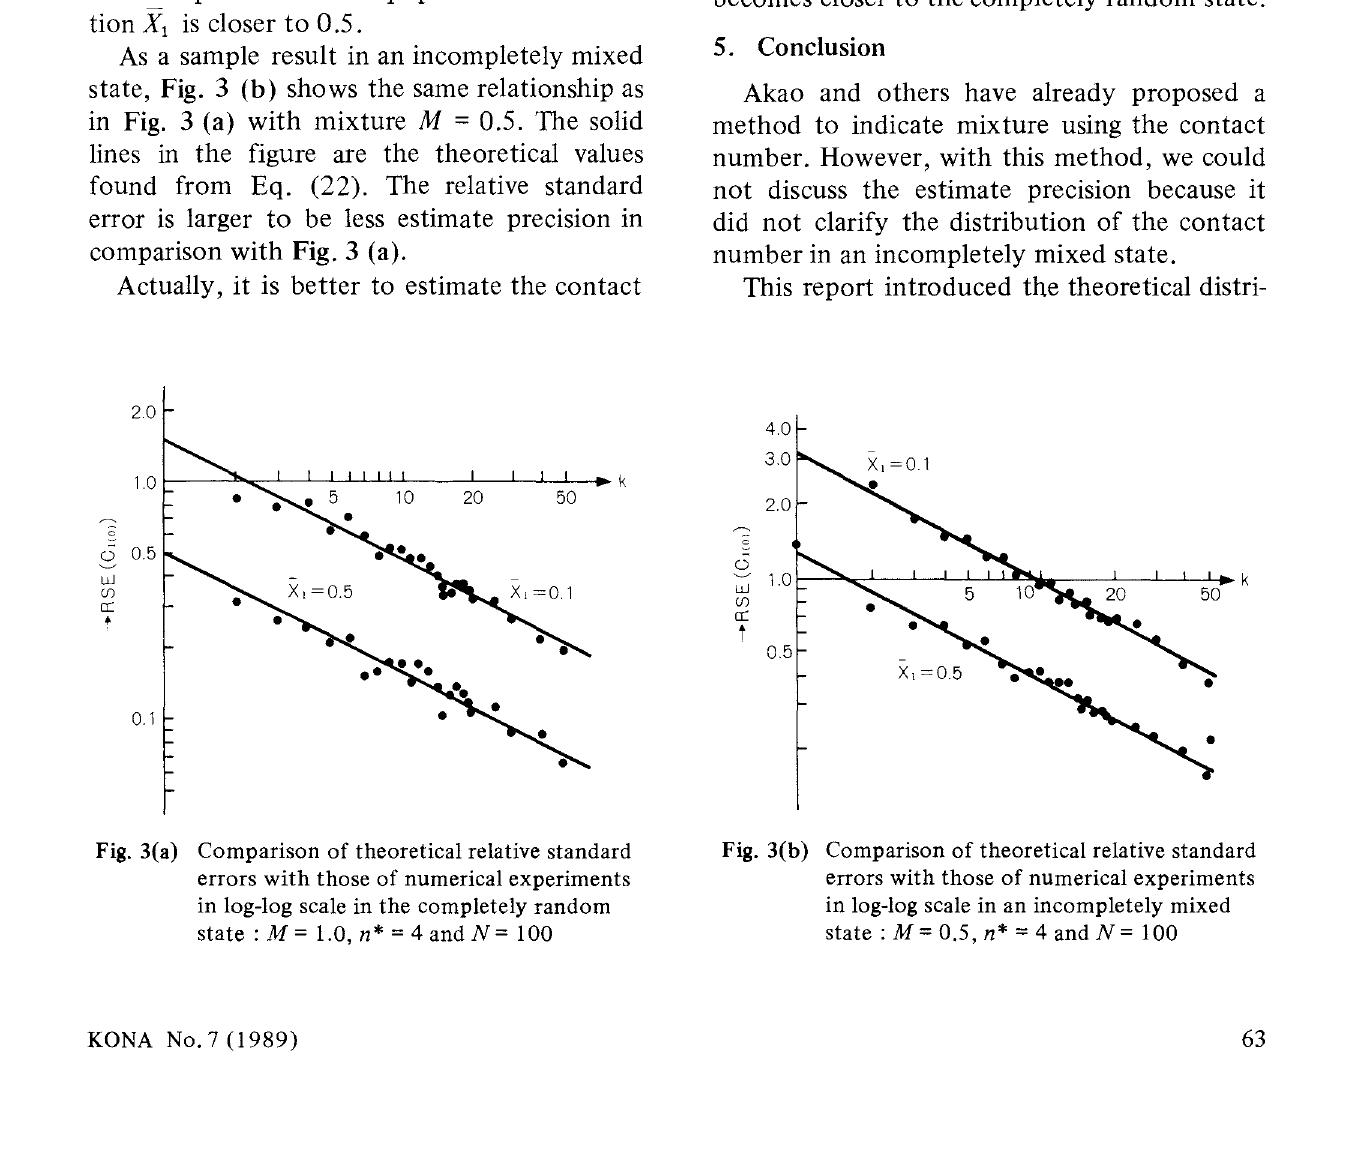
Fig. 3(a) Comparison of theoretical relative standard errors with those of numerical experiments in log-log scale in the completely random state: M = 1.0, n* = 4 and N= 100